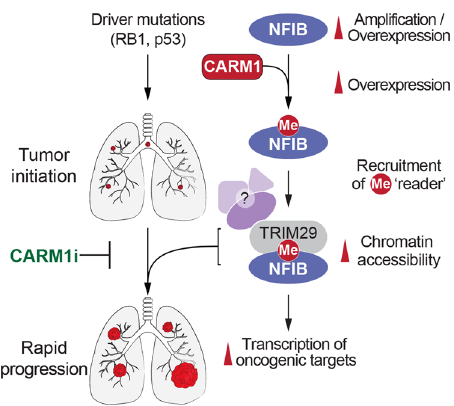
Fig. 5 | A model of CARM1-mediated NFIB regulation and SCLC therapeutic intervention. NFIB is methylated by CARM1, which subsequently recruits TRIM29 andpossiblyothereffectorsproteins.TRIM29itselflikelypartofaproteincomplex that promotes the transcriptional activity of NFIB. CARM1 inhibitors (CARM1i) will attenuate the oncogenic properties of NFIB ampli fi